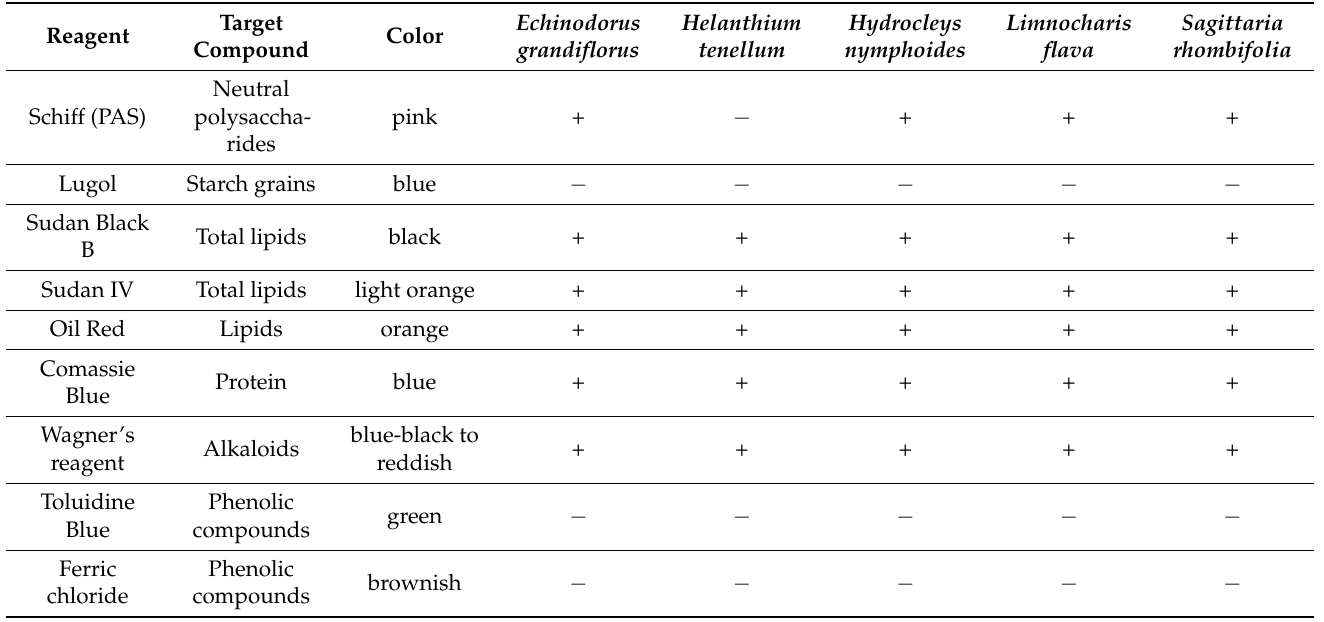
Table 2. Histochemical data obtained for the secretory duct secretion of Echinodorus grandiflorus , Helanthium tenellum, Hydrocleys nymphoides, Limnocharis flava and Sagittaria rhombifolia . Symbols: (+) presence; ( − ) absence.